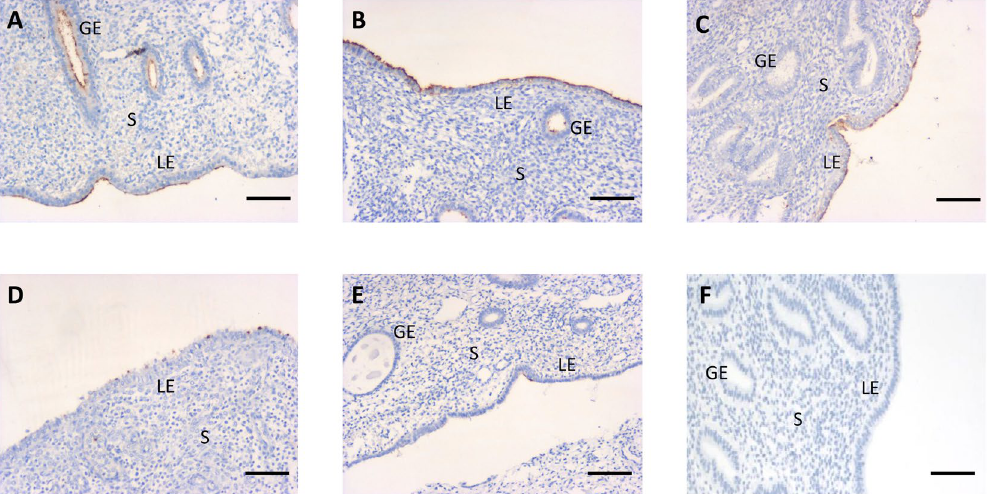
Figure 1. Immunohistochemical staining with MECA-79 in human endometrium for LSL expressed in patients with leiomyoma. Staining was patchy and much less intense during the proliferative phase than during the secretory phase. Weak staining intensity was found in menopausal endometrium. Endometrial tissues at ( A ) proliferative (cycle days 7–14), ( B ) early-secretory (cycle days 15–19), ( C ) mid-secretory (cycle days 20–24), ( D ) late-secretory (cycle days ≧ 25) phases, ( E ) menopause, and ( F ) negative control. LE = luminal epithelium; GE = glandular epithelium; S = stroma. Original magnification 40 × . Scale bar = 50 μ m.